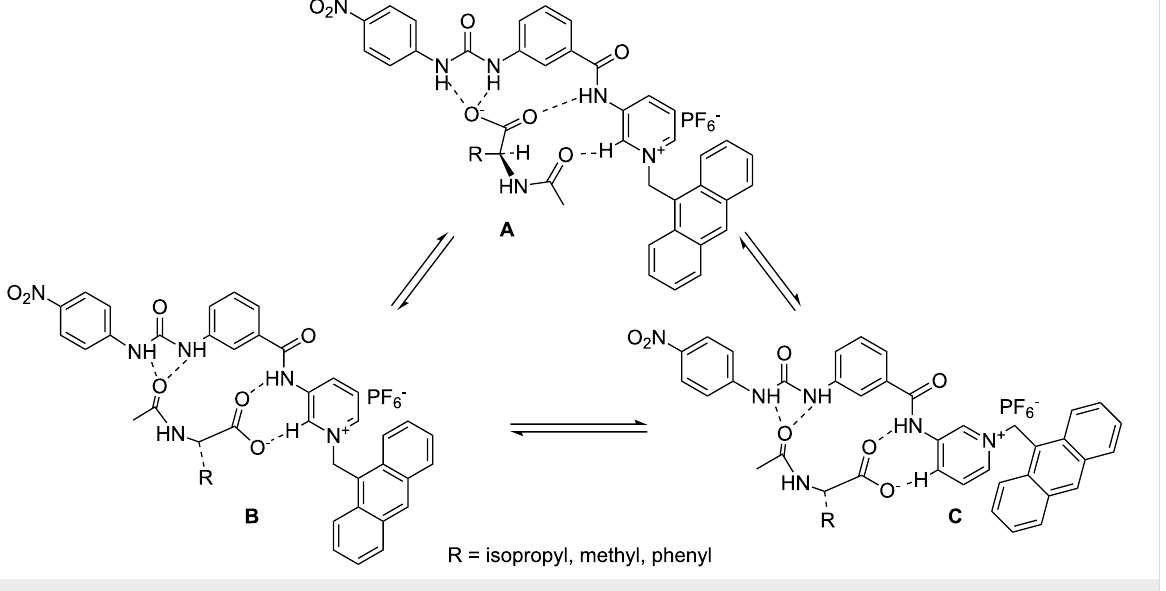
Figure 5: Suggested modes of binding of the amino acid salts into the open cleft of 1 .